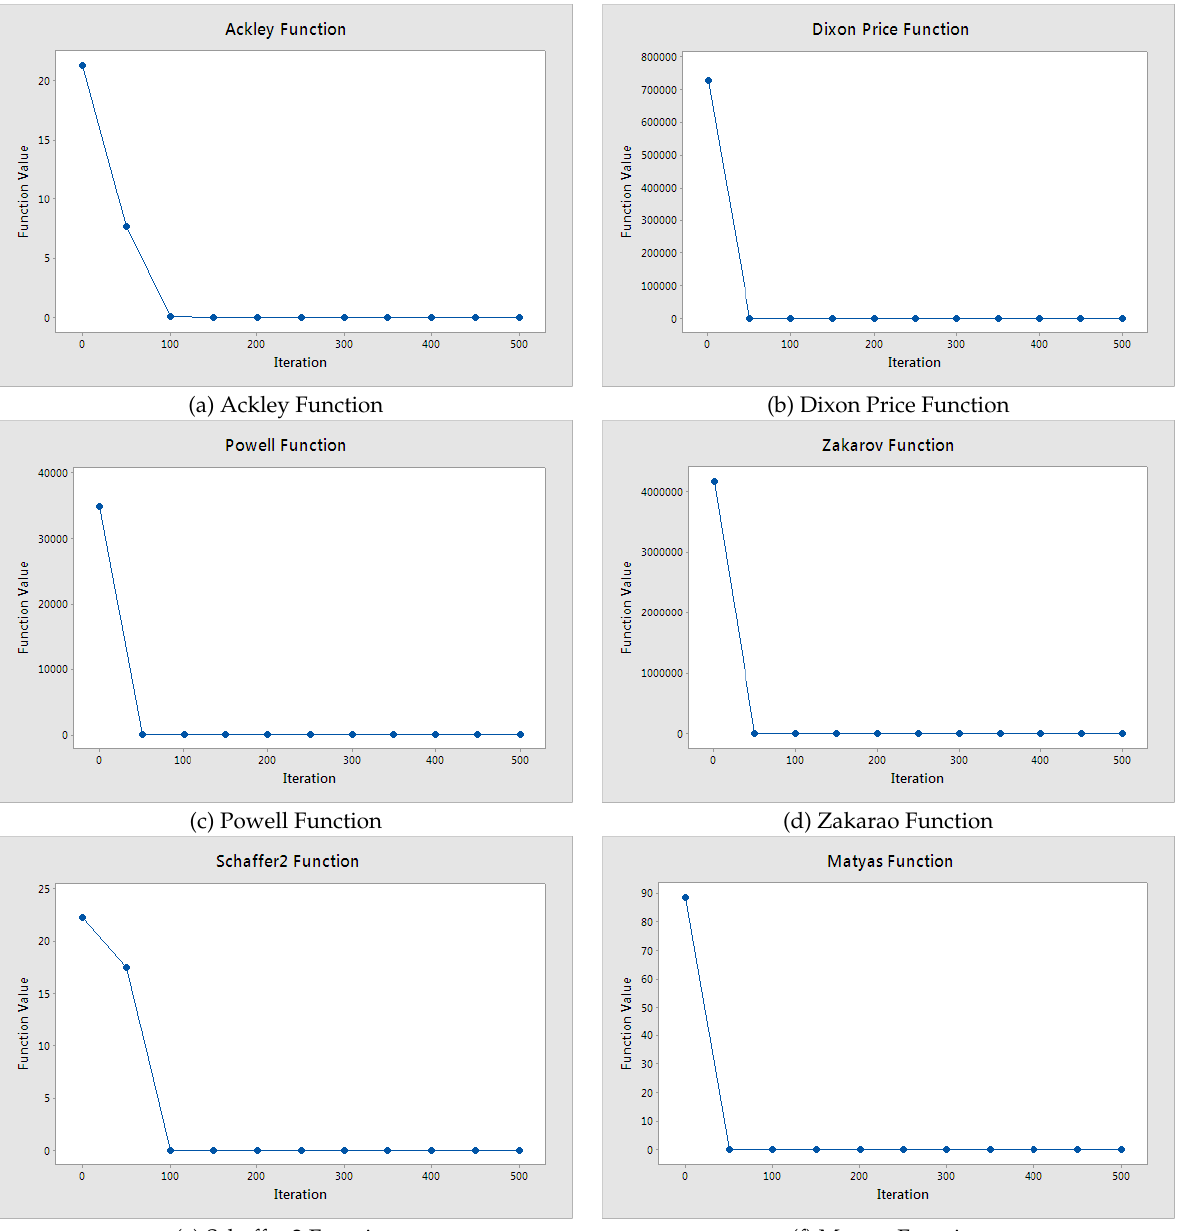
Fig. 3. The Function Values vs No. of Iterations